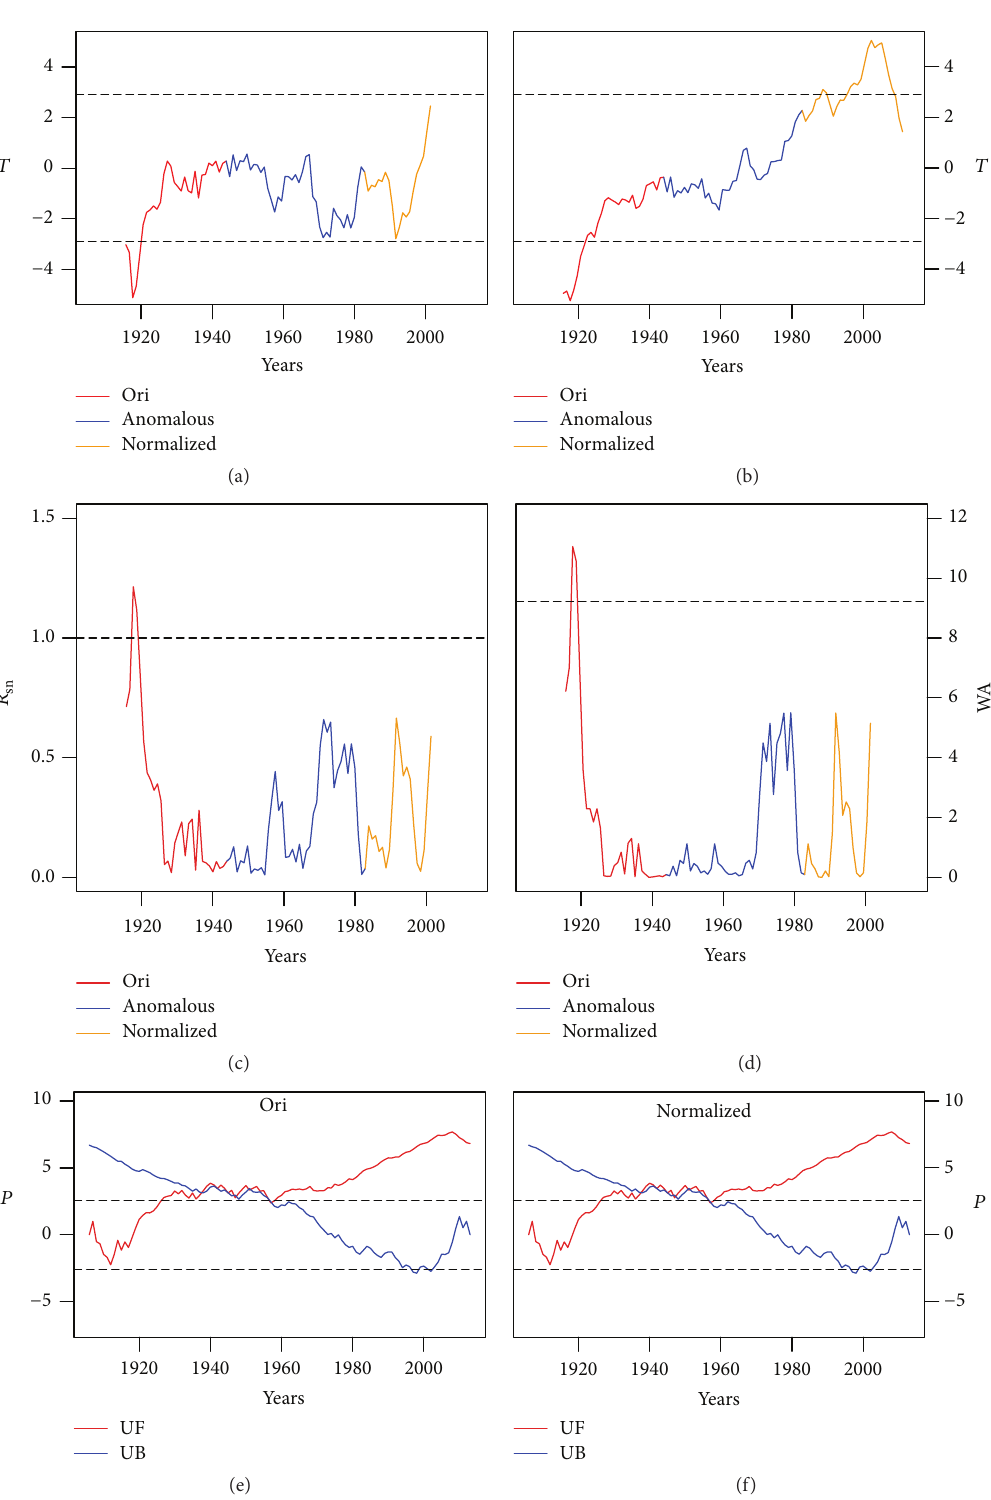
Figure 8: Effects of removing the mean and normalization on five detection methods: (a) MTT, (b) CRA, (c) YAMA, (d) LP, and (e) MK for the original series and (f) MK for the normalized